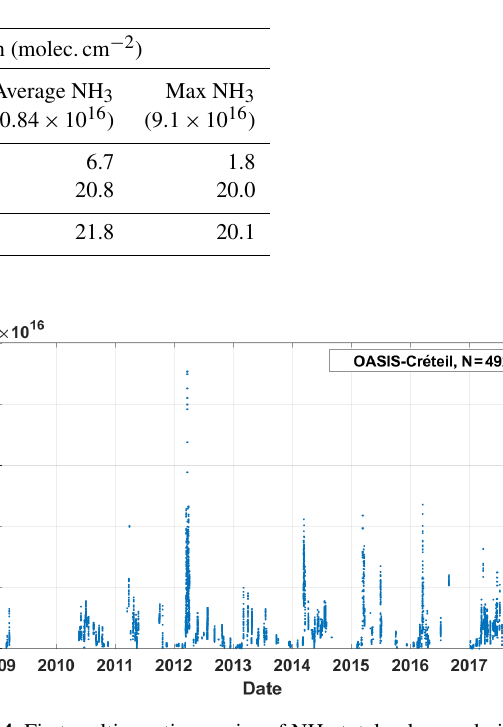
Table 1. Random and systematic errors according to NH 3 total columns. The total errors, combining the systematic and random errors, vary from 20% up to 35%. Note that 9 . 1 × 10 16 molec.cm 2 is the maximum ammonia column measured over Paris during the 2009–2017 period (which occurred exactly in March 2012).